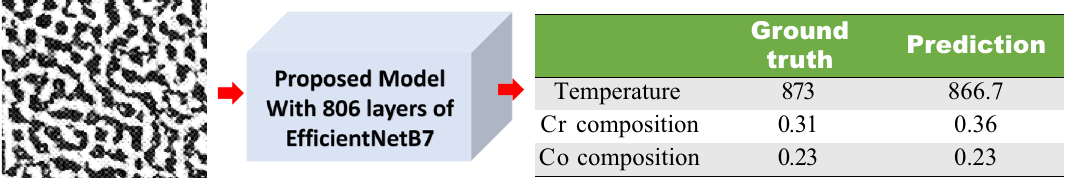
Figure 9. Prediction of chemistry and processing temperature for an experimental TEM image adopted from Okada et al. 94 . The original image was cropped to be in the desired size of 224 × 224